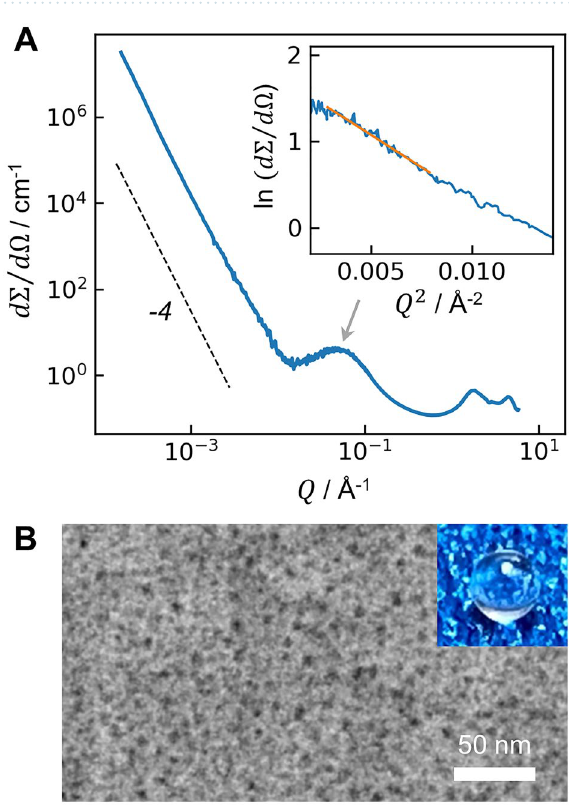
Figure 1. Metastable liquid–liquid immiscibility in SiO 2 -Al 2 O 3 . Numerous locations for the miscibility gap have been proposed based on experimental observations of quenched glasses and thermodynamic calculations (colored curves with Ref. numbers given in figure). The compositional and temperature limits of immiscibility vary substantially between studies, with the Al 2 O 3 -rich endmember intersecting T g anywhere from 56 to > 85 mol. %. Equilibrium phase diagram adapted from Mao et al. 11 . Glass transition is T g 7 , and crystallization of glasses upon heating is T x 41 .